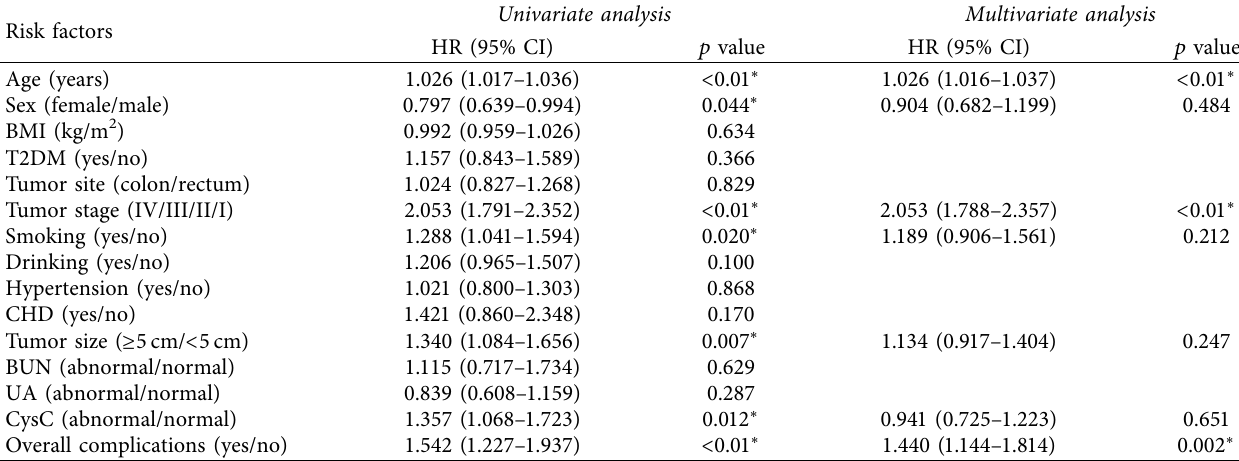
Table 5: Univariate and multivariate analyses of disease-free survival.